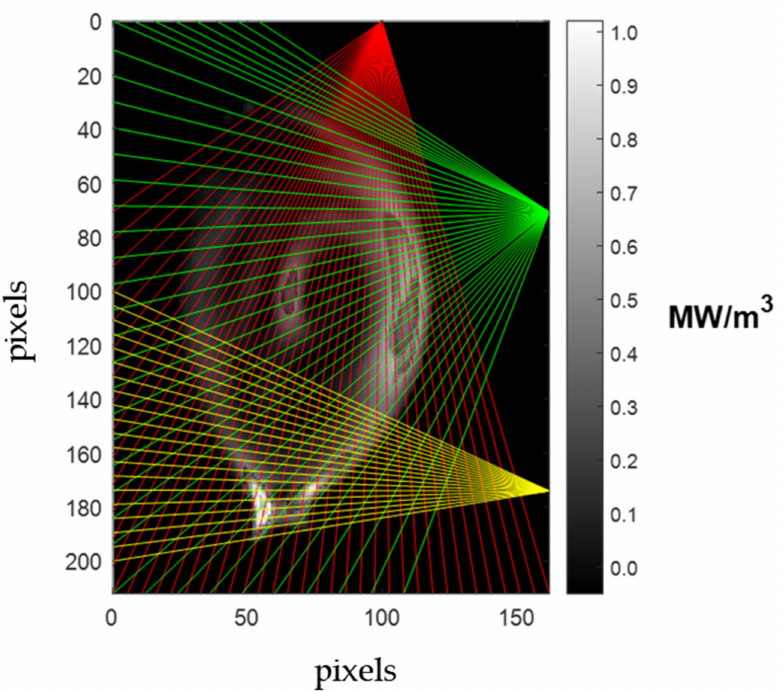
Figure 1. Line of sights of the considered bolometer. The grey scale refers to emissivity values in MW/m 3 . The x and y axes report the number of pixels considered along the radial (r) and vertical (z) directions respectively resulting in an investigated area of 162 × 212 pixels.